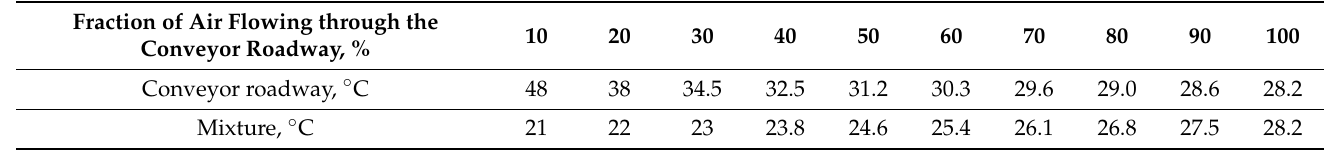
Table 2. Air temperatures at the end of the conveyor roadway and mixed airflow after entering the longwall working area.